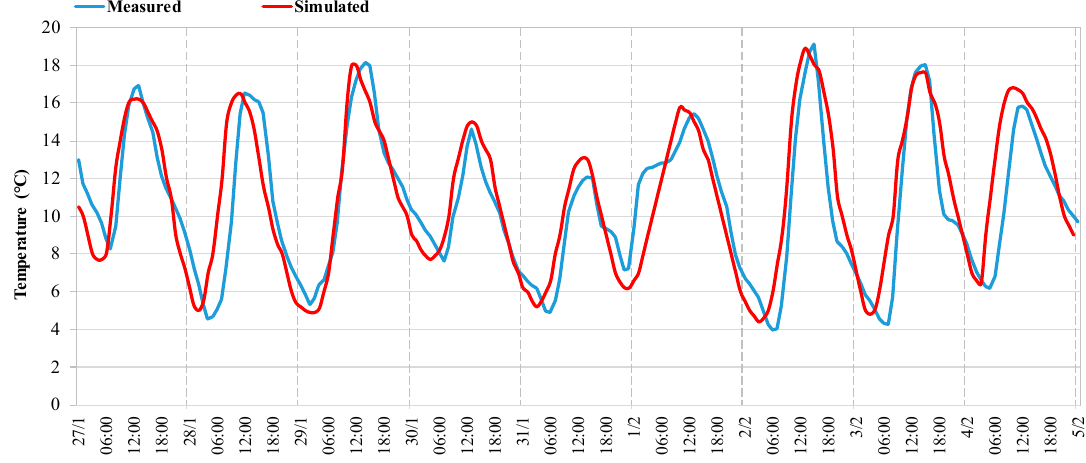
Figure 3. Trend of measured and the model-predicted indoor air temperatures.